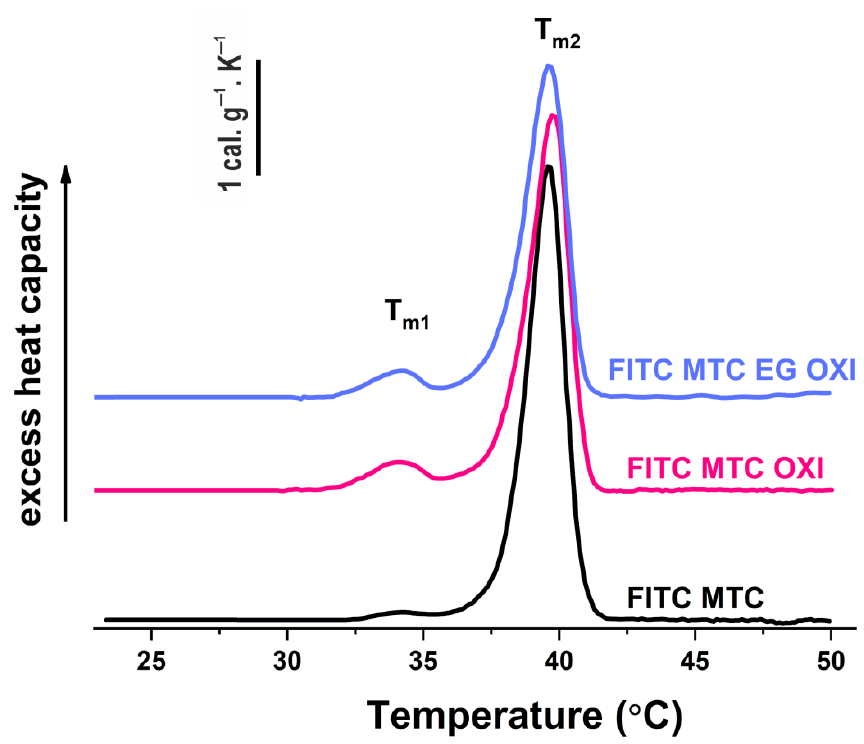
Figure 8. DSC thermograms of native FITC-MTC (black line), oxidized FITC-MTC-OXI (purple line), and EGCG pretreated FITC-MTC-OXI/EGCG (blue line) samples.